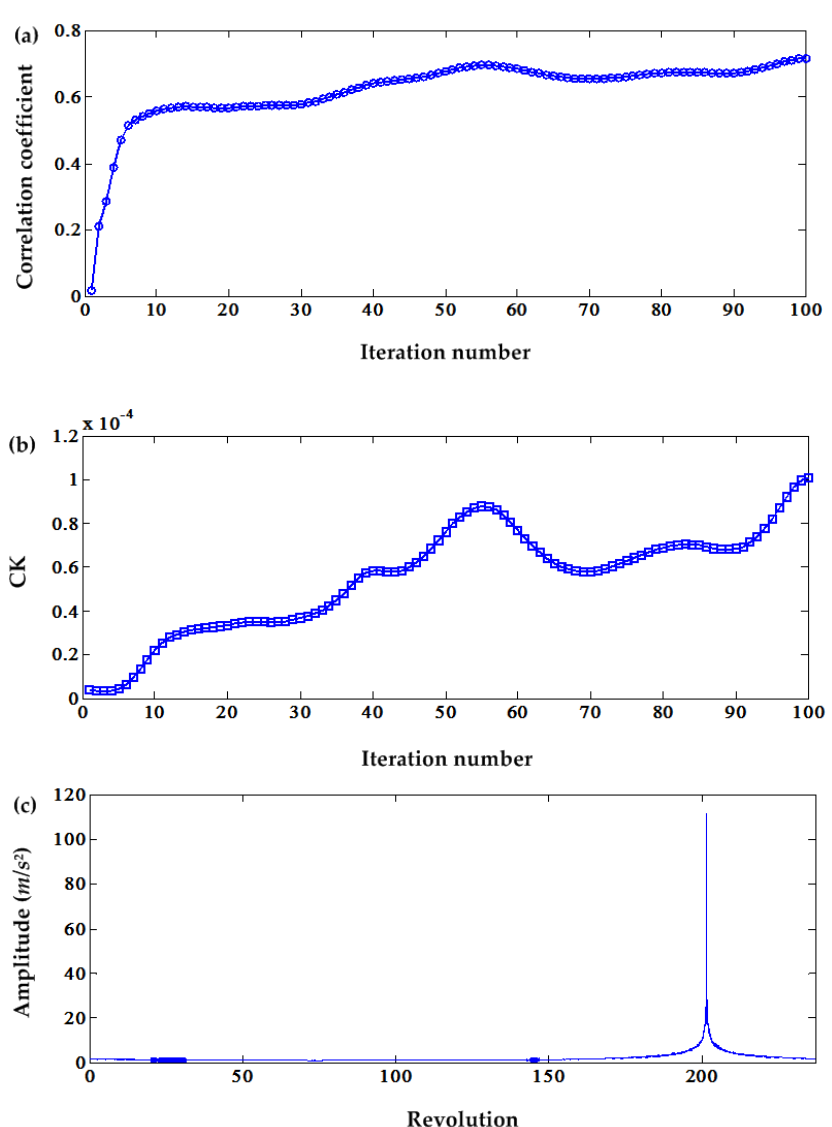
Figure 12. ( a ) Correlation coefficient vs. iteration number; ( b ) CK value vs. iteration number; ( c ) Squared envelope signal after the 100th DC offset cancellation.